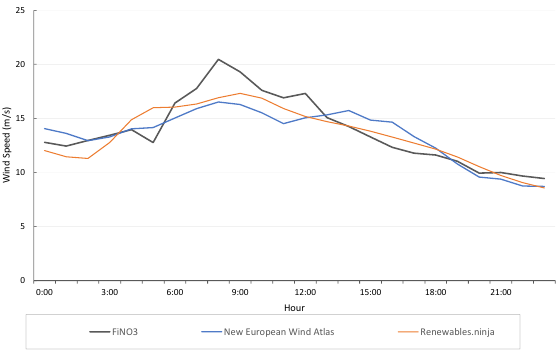
Figure 21. Hourly comparison (1 January 2018). Own elaboration.